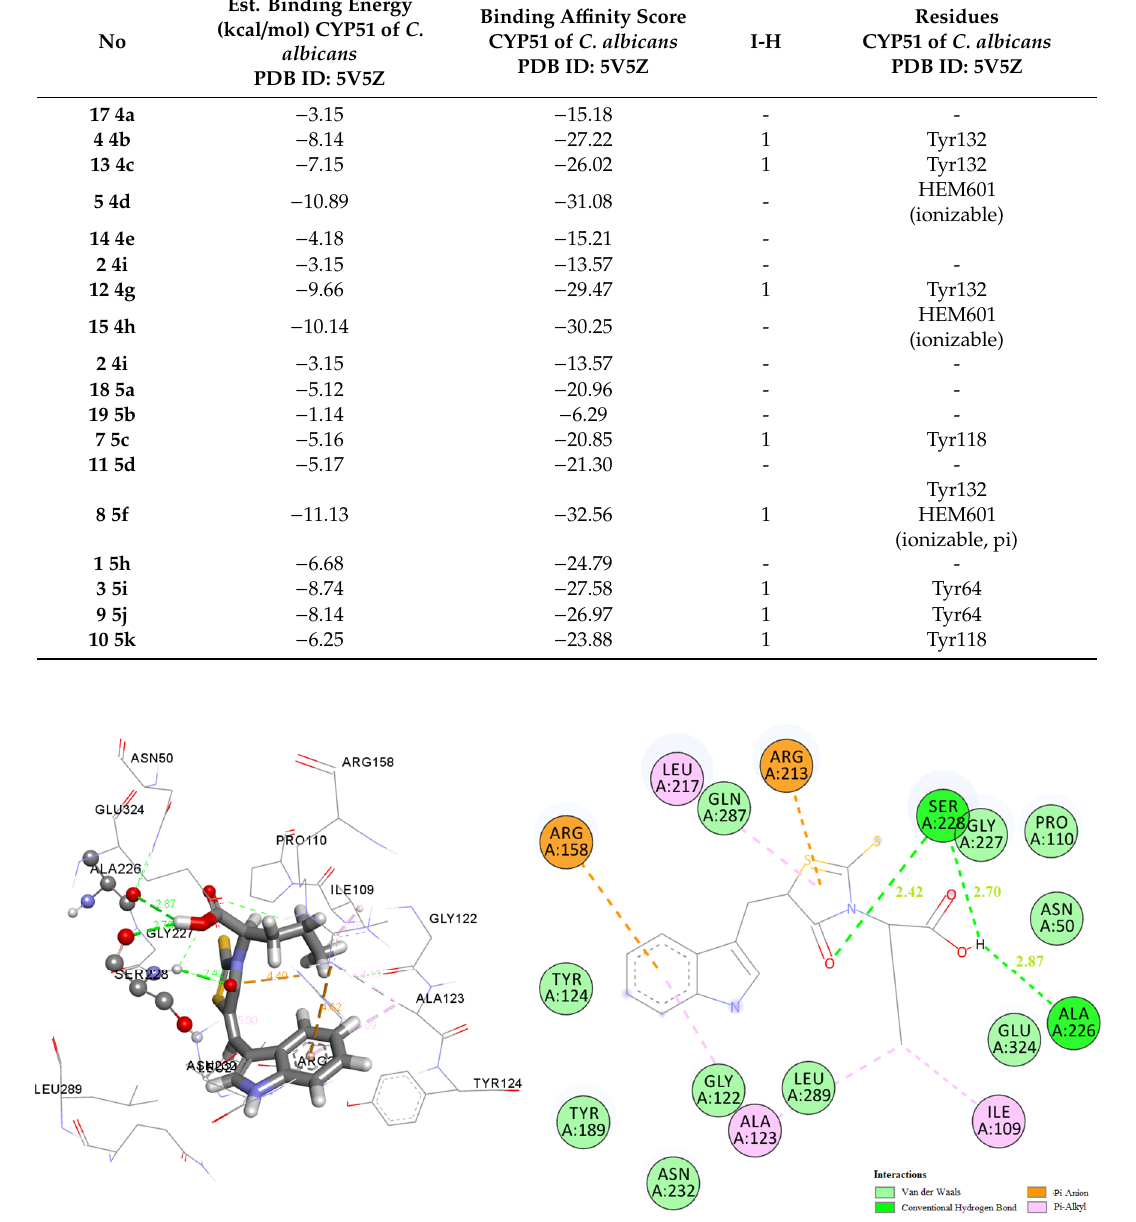
Figure 1. Docked conformation of the most active compound 5b in E. coli MurB.